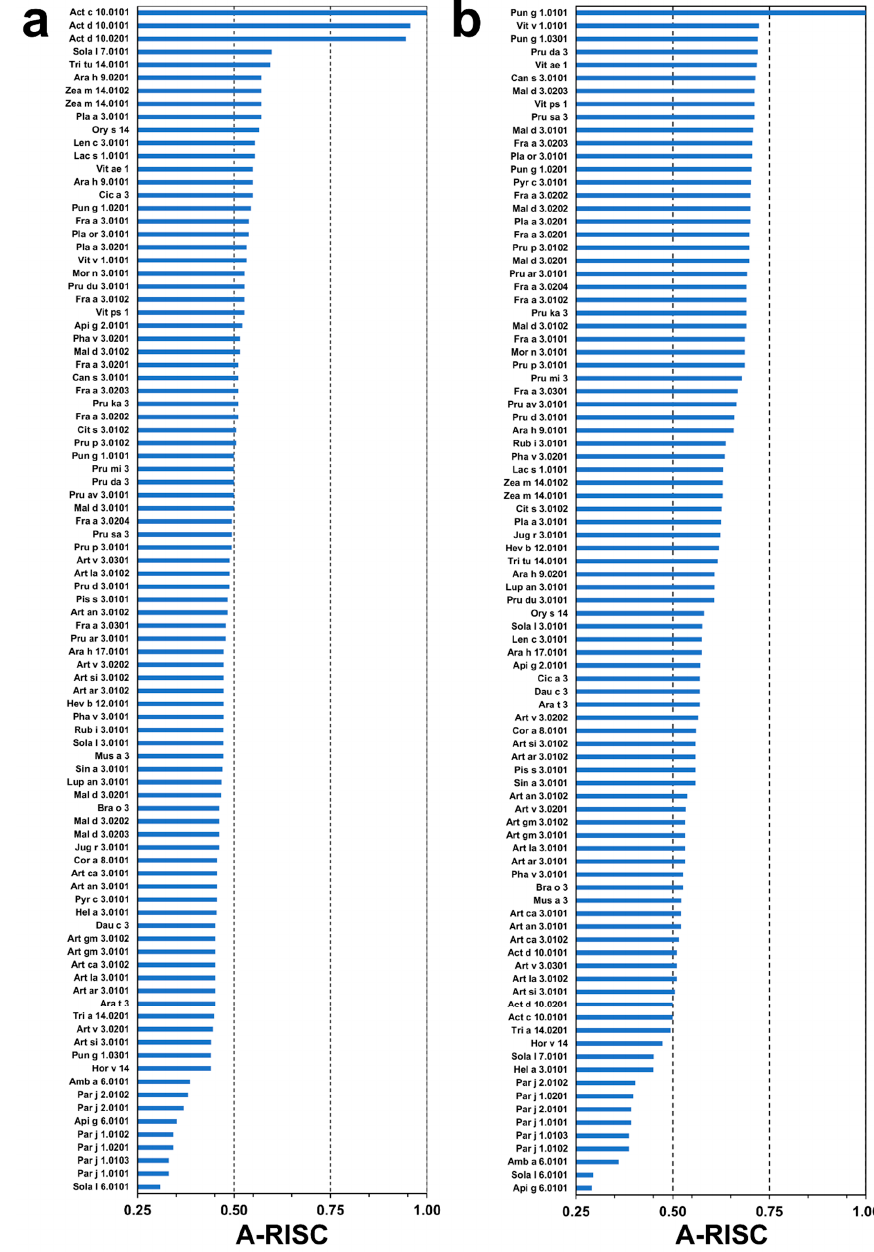
Figure 6 . Plots showing Allergens’-Relative Identity, Similarity and Cross-reactivity (A-RISC) indexes of allergens from the nsLTP family. ( a ) Comparison of the family members to Act c 10.0101 and ( b ) Pun g 1.0101. Pun g 1.0101 shares 69% sequence identity with Pun g 1.0301 and 68% sequence identity with Pun g 1.0201. Therefore, it is not surprising that there is a relatively